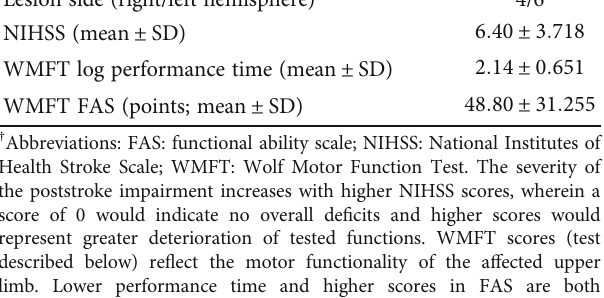
Table 2: Clinical data of stroke patients † . Time since stroke (days; mean ± SD